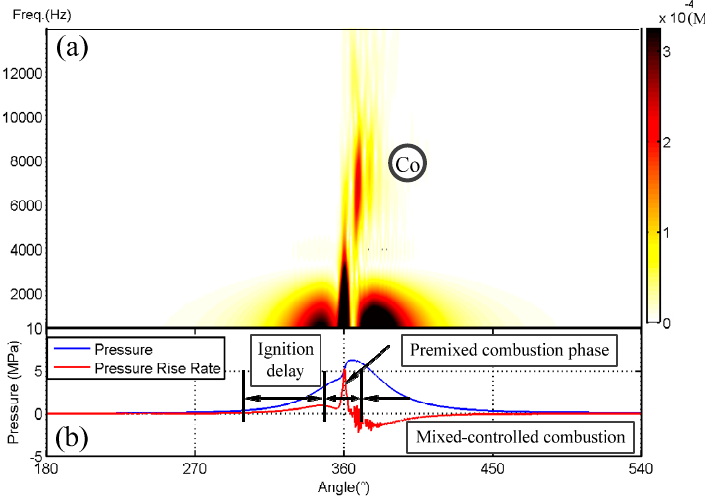
Figure 3. Short-time Fourier transform (STFT) of measured in-cylinder pressure; ( a ) STFT result of the pressure measured at engine speed of 1800 rpm and load of 40 Nm; ( b ) Raw pressure signal and the pressure rise rate.